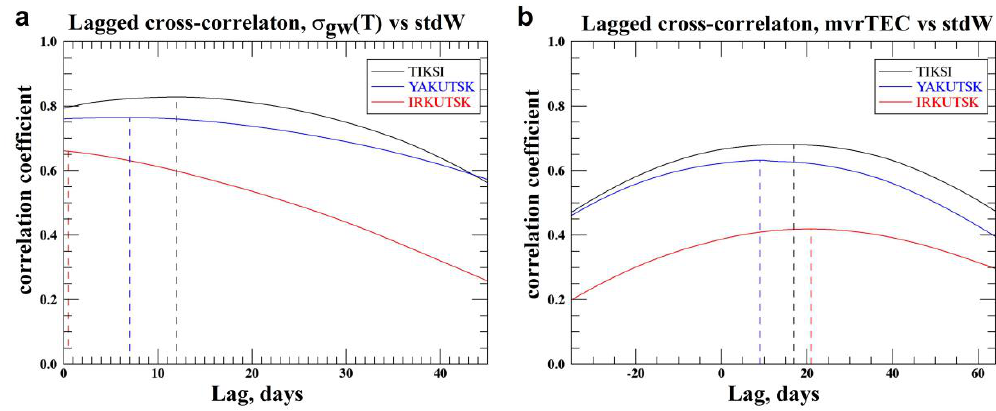
Figure 6. Scatter-plots between the variability indices in the stratosphere at 1 hPa and in the mesosphere at Maimaga ( a ) and Tiksi ( b ).